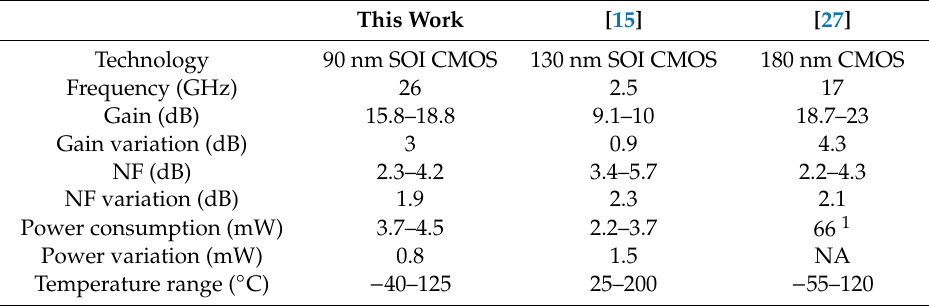
Table 3. Performance comparison table at di ff erent temperatures. This